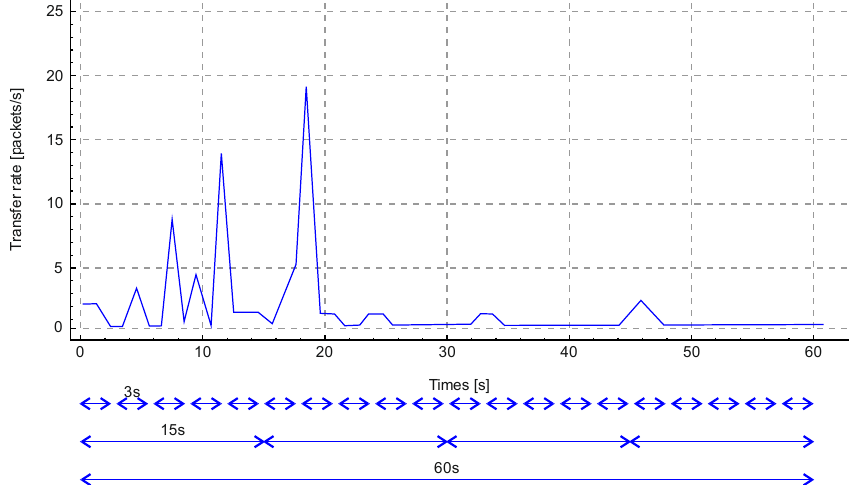
Figure 5. The graph of TCP (Transmission Control Protocol) packets of web traffic distribution for the monitoring period of 60 seconds. Table 2. Subscriber tables for TCP packets of web traffic.